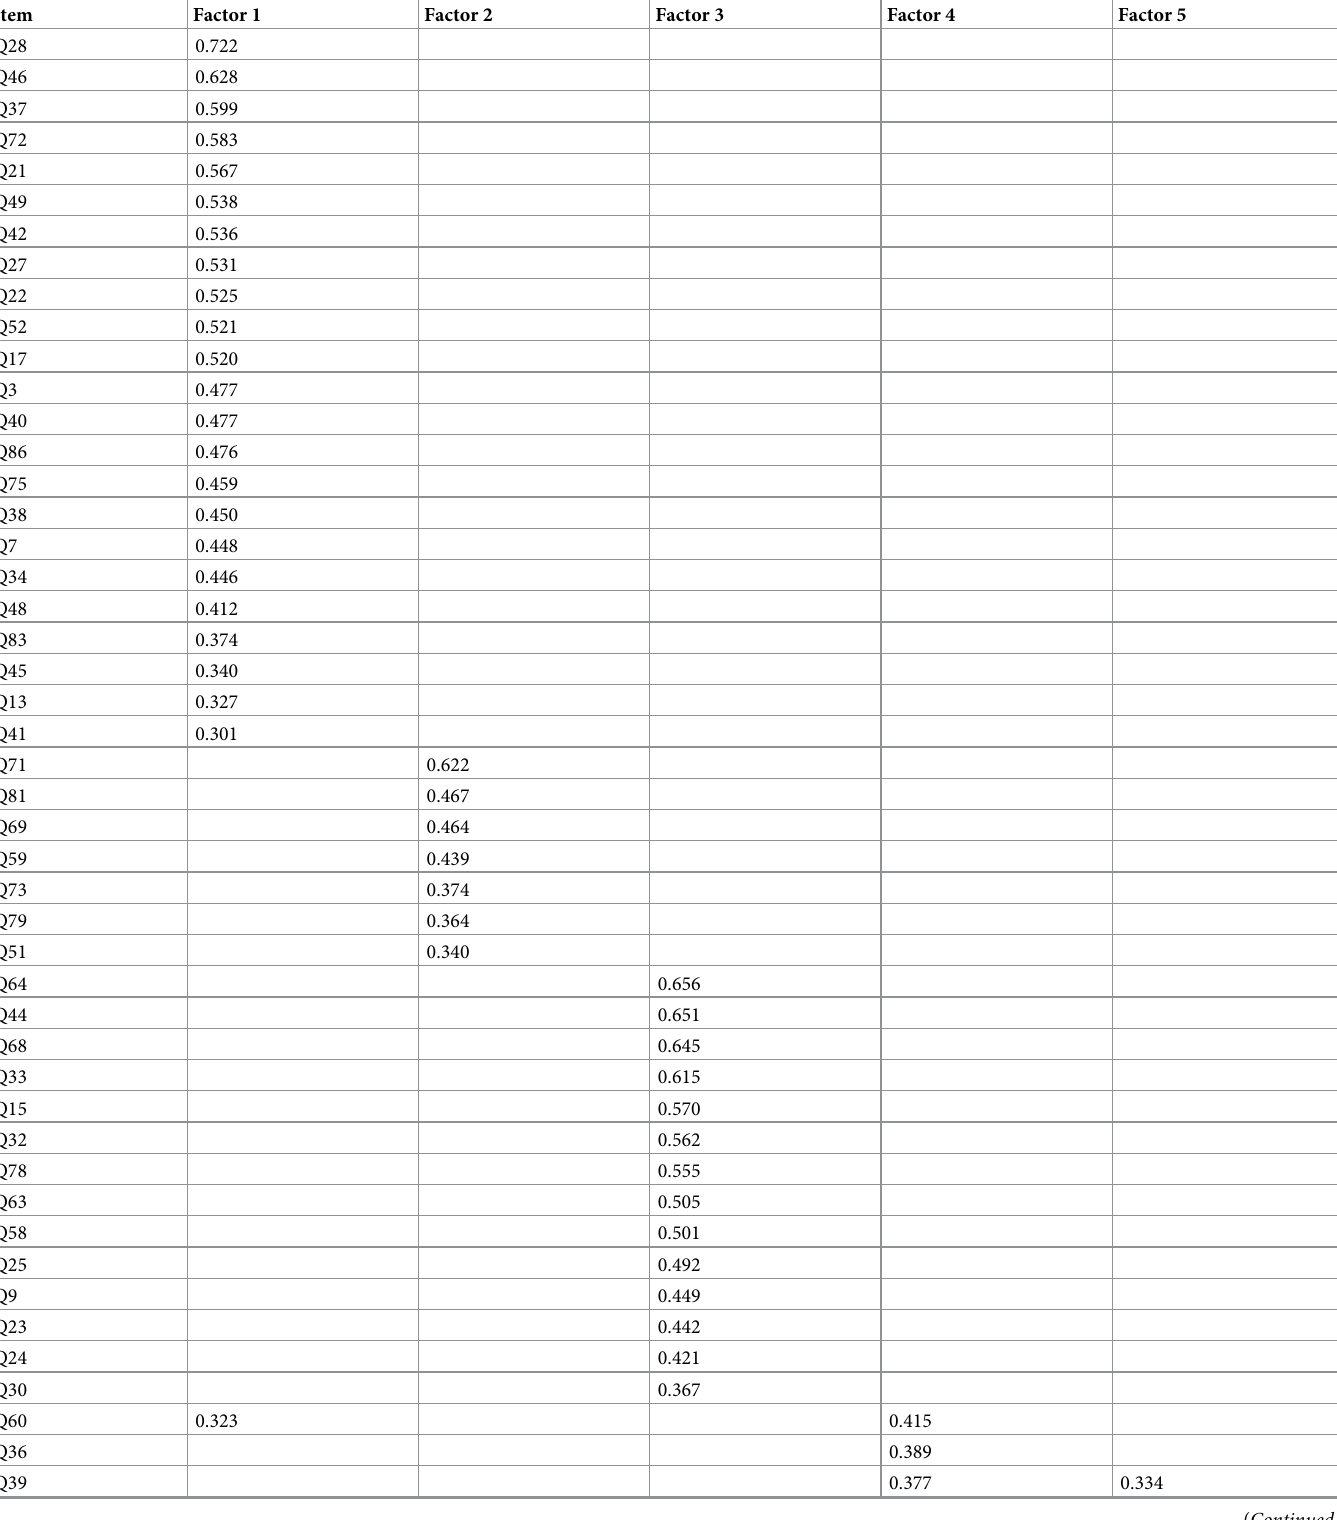
Table 3. Factor loadings for 53-item Psychological Characteristics of Developing Excellence Questionnaire for